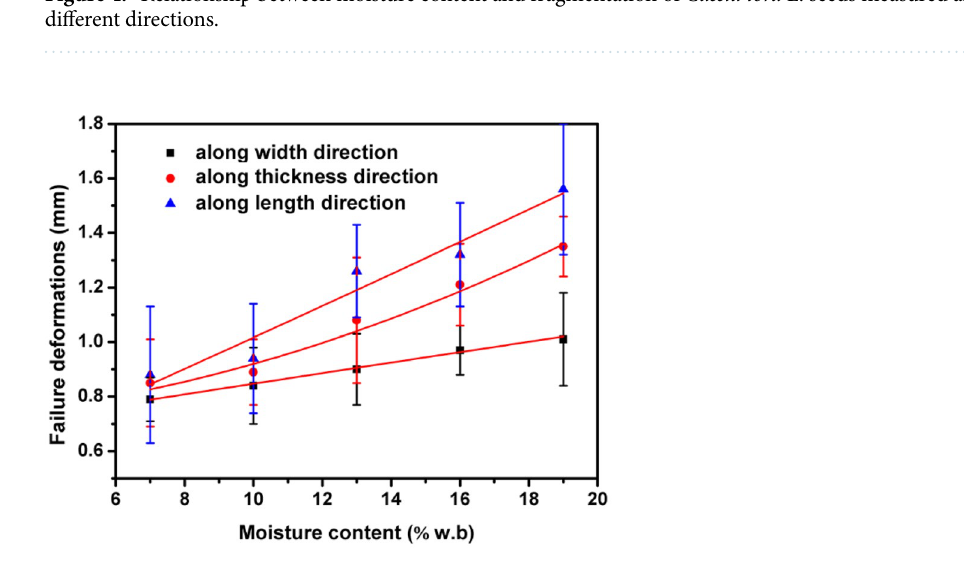
Figure 5. Relationship between moisture content and failure deformations of Cassia tora L. seeds measured along different